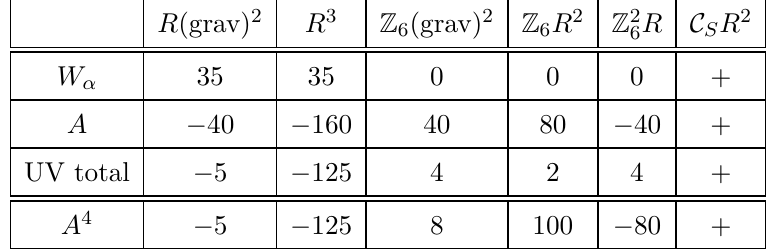
Table 14 . Anomaly matching conditions between the UV and IR. The R -charge of A is − 1 so that U(1) is anomaly free under the SU(6) gauge group. Note that the Z R matched because it is broken to Z due to the A 2 WW condensate. On the other hand, the charge 2 conjugation anomalies had not been studied before, and are matched